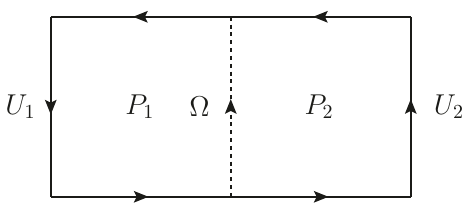
Figure 14 . The K-functional K 2 (cid:2) 1 for a 2 1 rectangle is obtained by considering the K-functional (cid:2) for the two plaquettes P 1 = U 1 (cid:10) and P 2 = (cid:10) (cid:0) 1 U 2 , which are glued together by integrating out the shared link variable